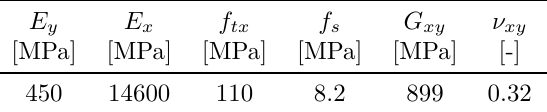
Table 1. Average values of input data for Yellow Poplar LVL from standard tests [1,